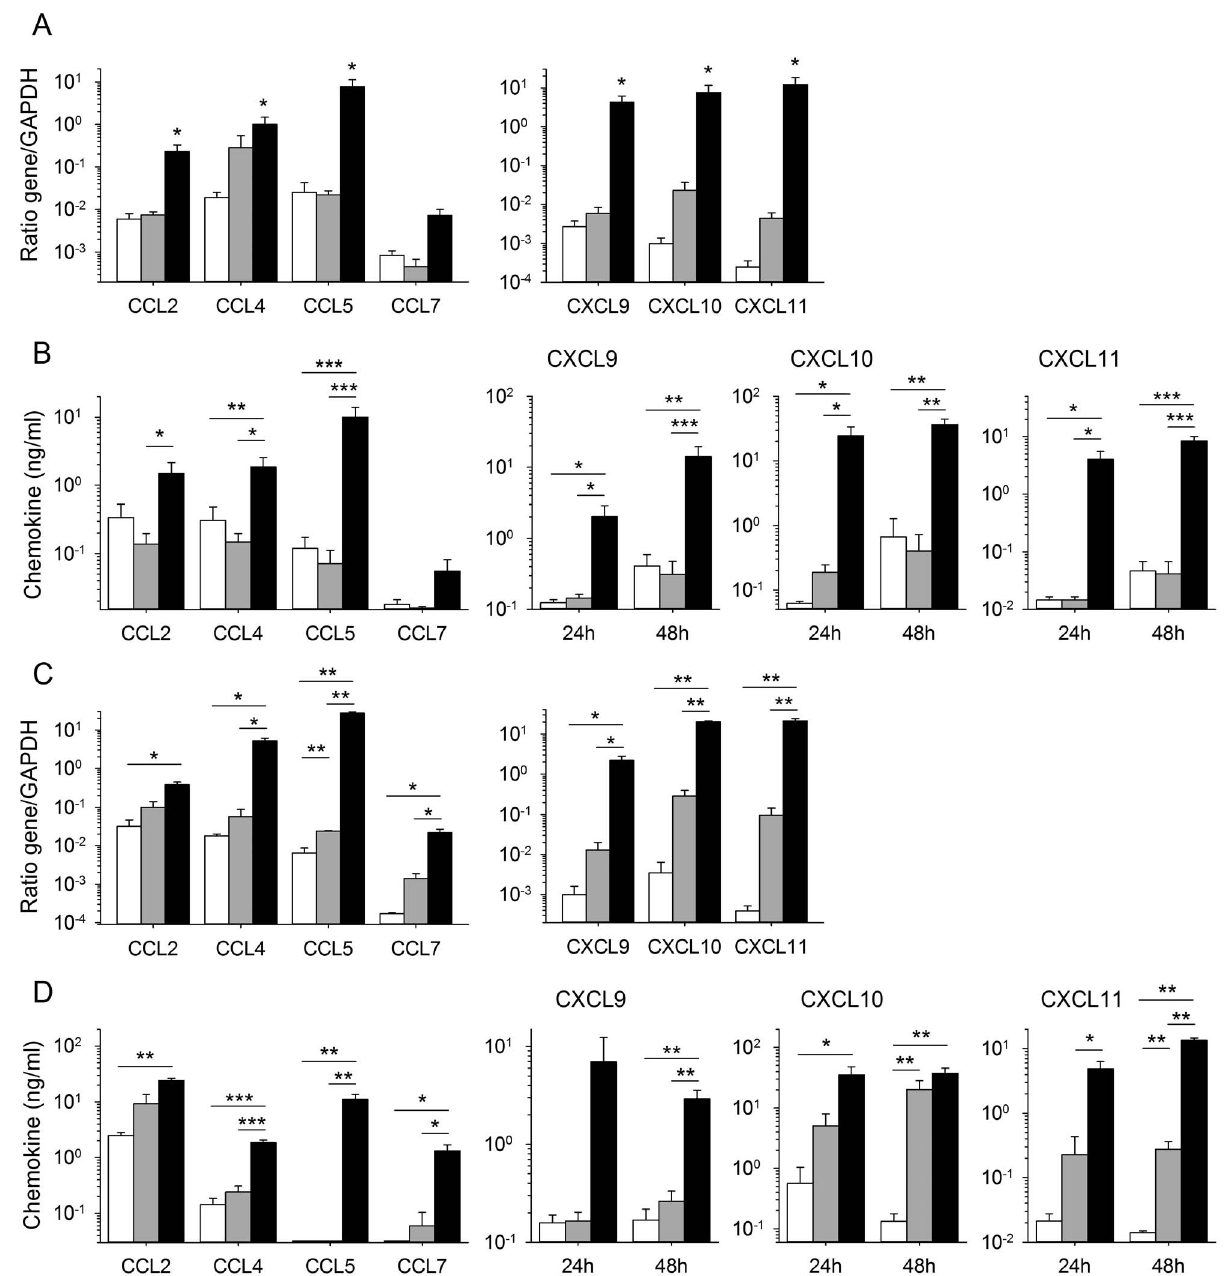
Figure 5. Production of chemokines by APC infected with recombinant LASV. The production of CC and CXC chemokines by DC (A, B) and MP (C, D) was assessed after mock infection (white bars), or infection with recombinant wild-type LASV (gray bars) or rLASV NP-D389A/G392A (rNP LASV) (black bars). (A, C) The synthesis of mRNAs was analyzed by RT-qPCR 24 h after infection. (B, D) The protein levels released in the supernatants were quantified by ELISA 24 h (only for CXCL9, 10 and 11) and 48 h after infection. Results are expressed as the mean 6 SE of 4 (A, C) and 3–7 (B, D) independent experiments. Significant differences are indicated as follows: * ( p , 0.05), ** ( p , 0.01) and *** (p , 0.001).